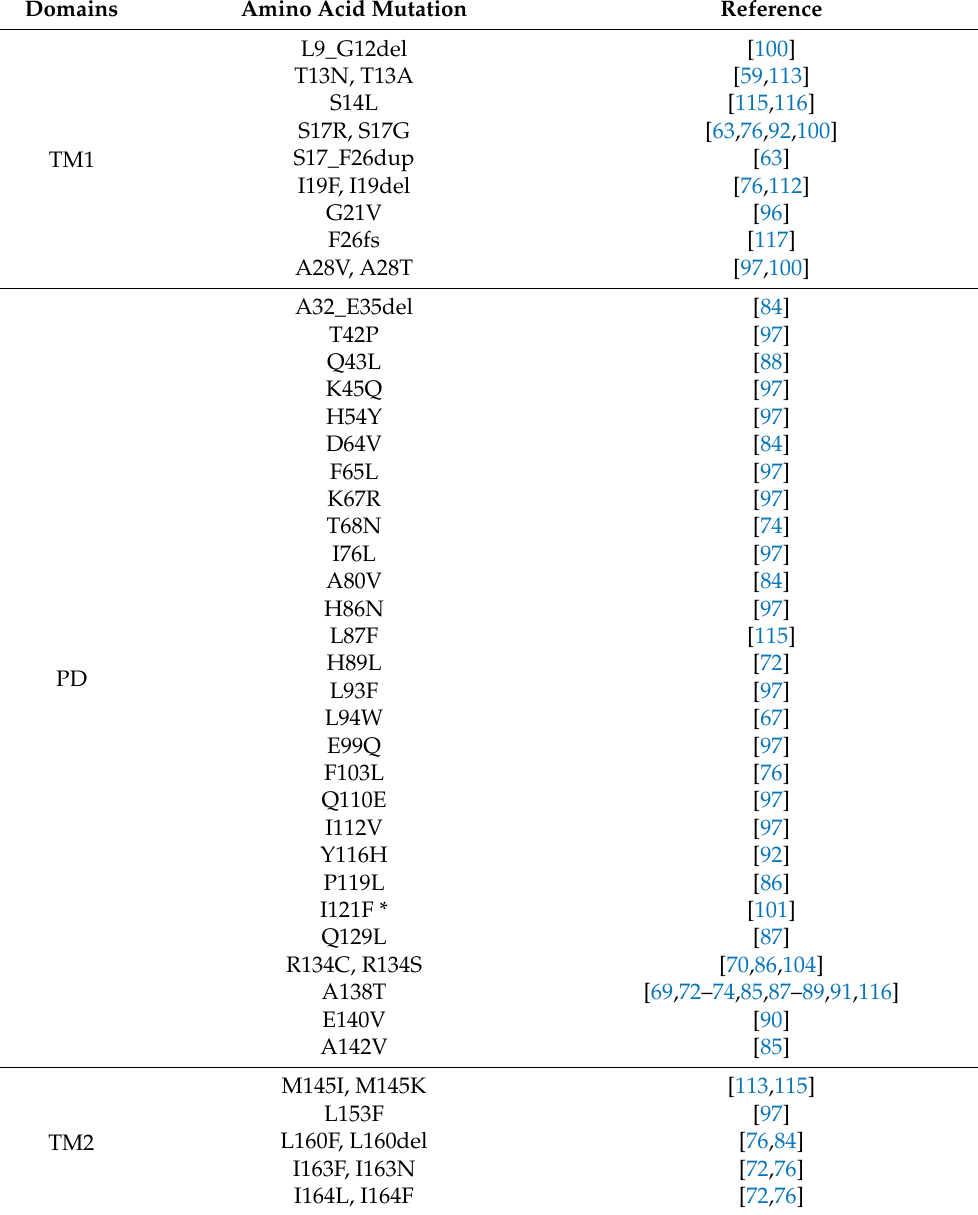
Table 1. Overview of PmrB sensor kinase mutations in colistin-resistant A. baumannii .